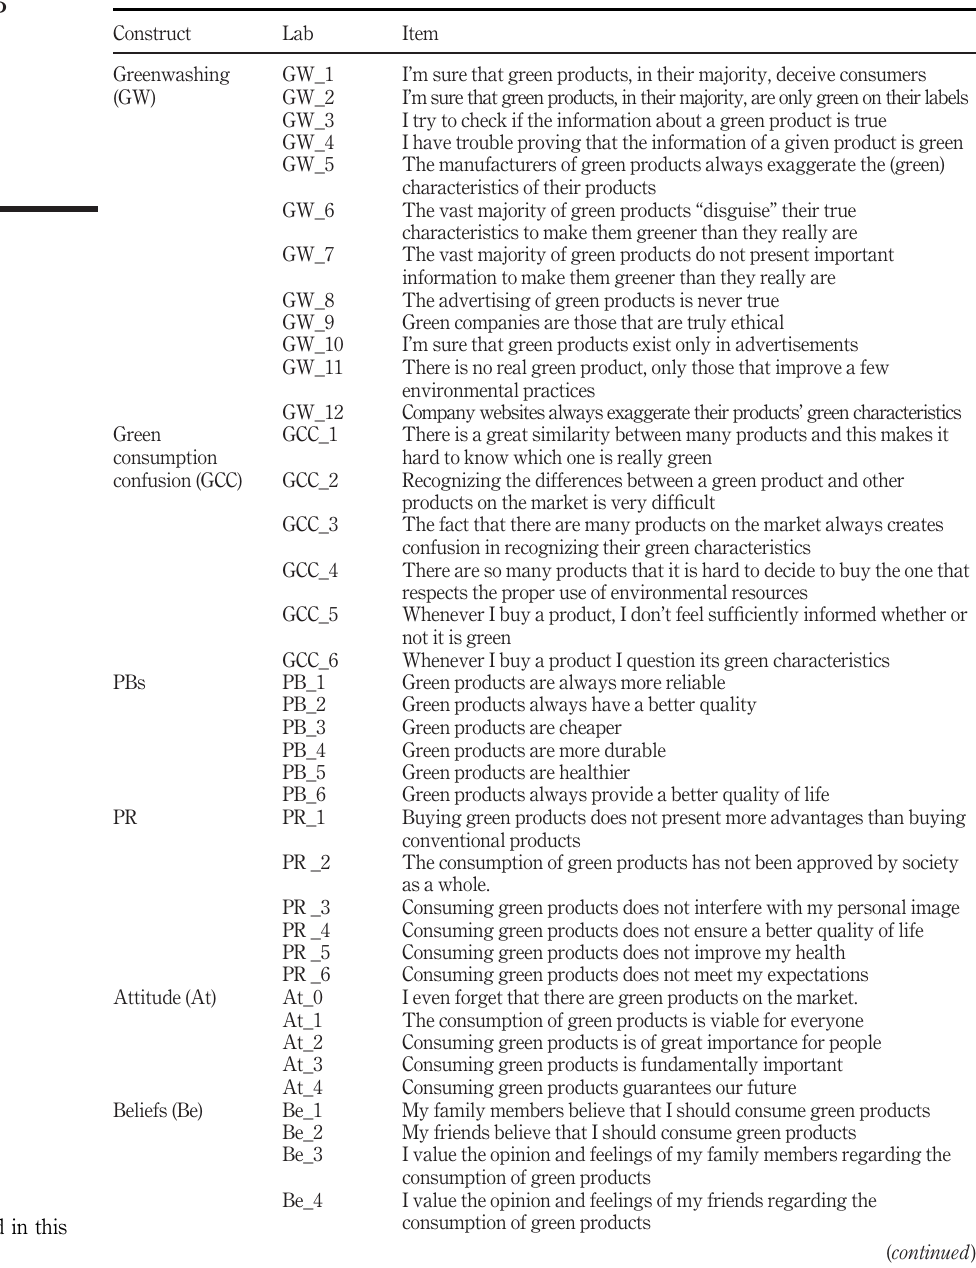
Table I. Scale used in this